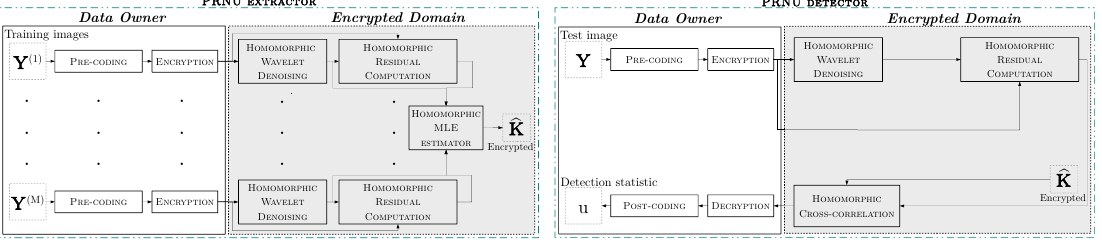
Figure 1. The secure PRNU extractor/detector proposed in